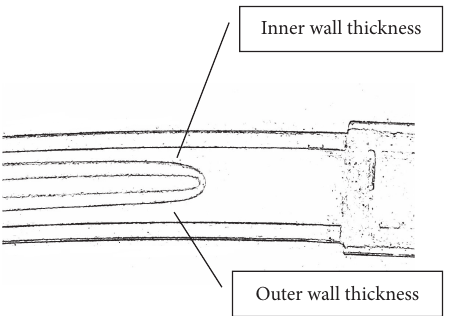
Figure 19: Difference is defined within the outer gap.